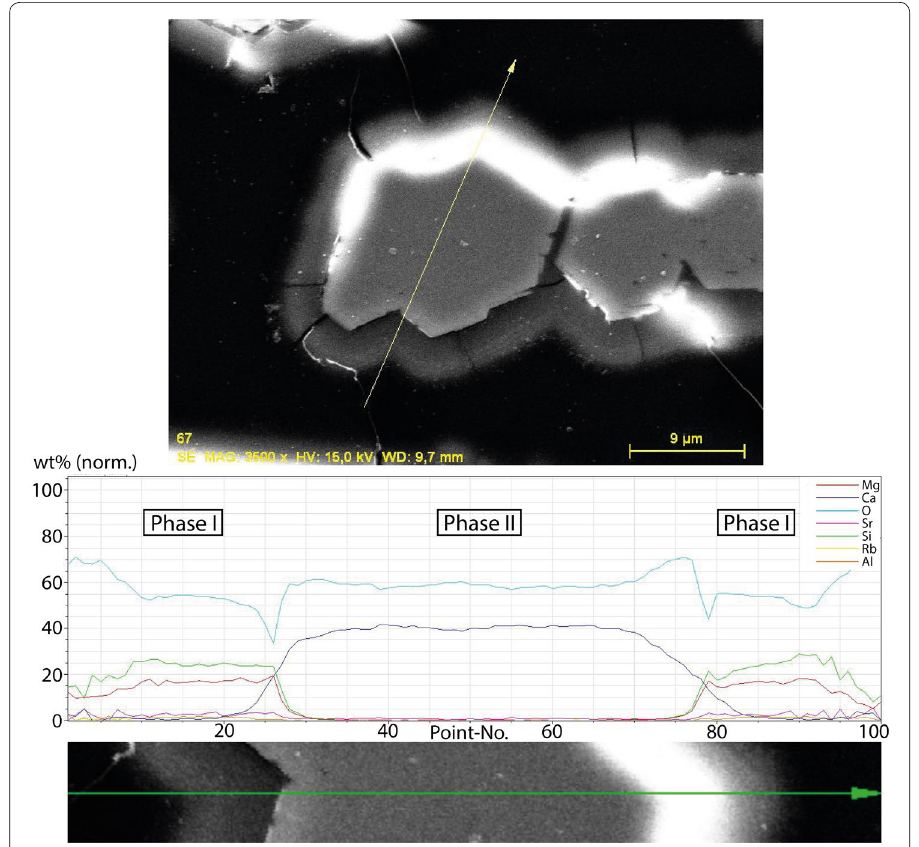
Fig. 3 SEM image of the thin section IS_Strýtan_01. The micrometer-scale layers are well visible. The different colors are the result of varying material properties (the higher the atomic number, the lighter the color). The yellow arrow marks the orientation of the profile given below. The diagram documents the chemical behavior along the profile ( green arrow ). This EDX line scan confirms different materials, although no mineral phase identification is possible by the use of this method. The outer parts are characterized by a dominance of Si, Mg, and O ( phase I ). The inner parts are dominated by Ca and O ( phase II